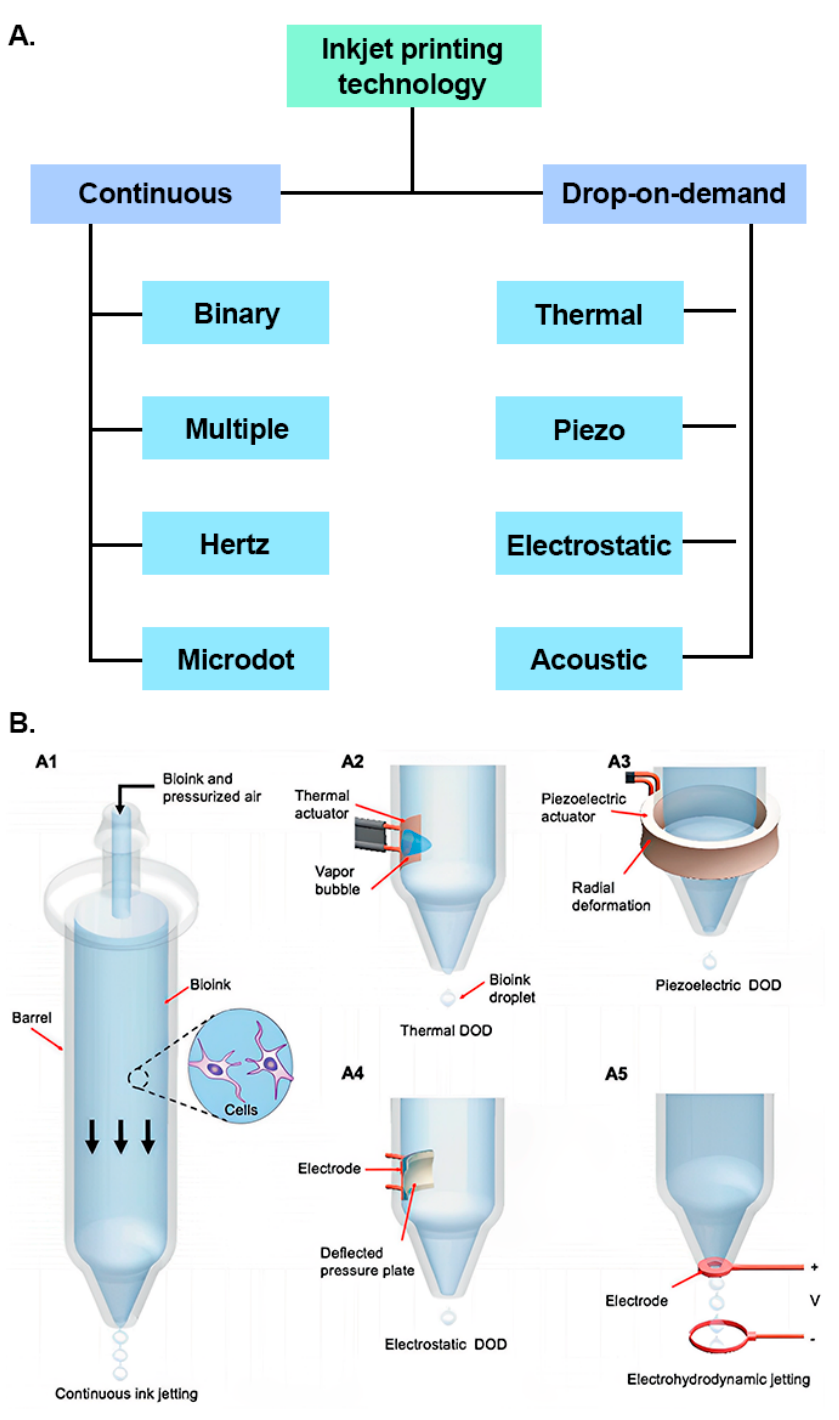
Figure 6. ( A ) Classification of IJP technology (reproduced from [94]). ( B ) Working principles of some of the different IJP techniques: ( A1 ) continuous, ( A2 ) thermal, ( A3 ) piezoelectric, ( A4 ) electrostatic, ( A5 ) electrohydrodynamic (modified from [95]).